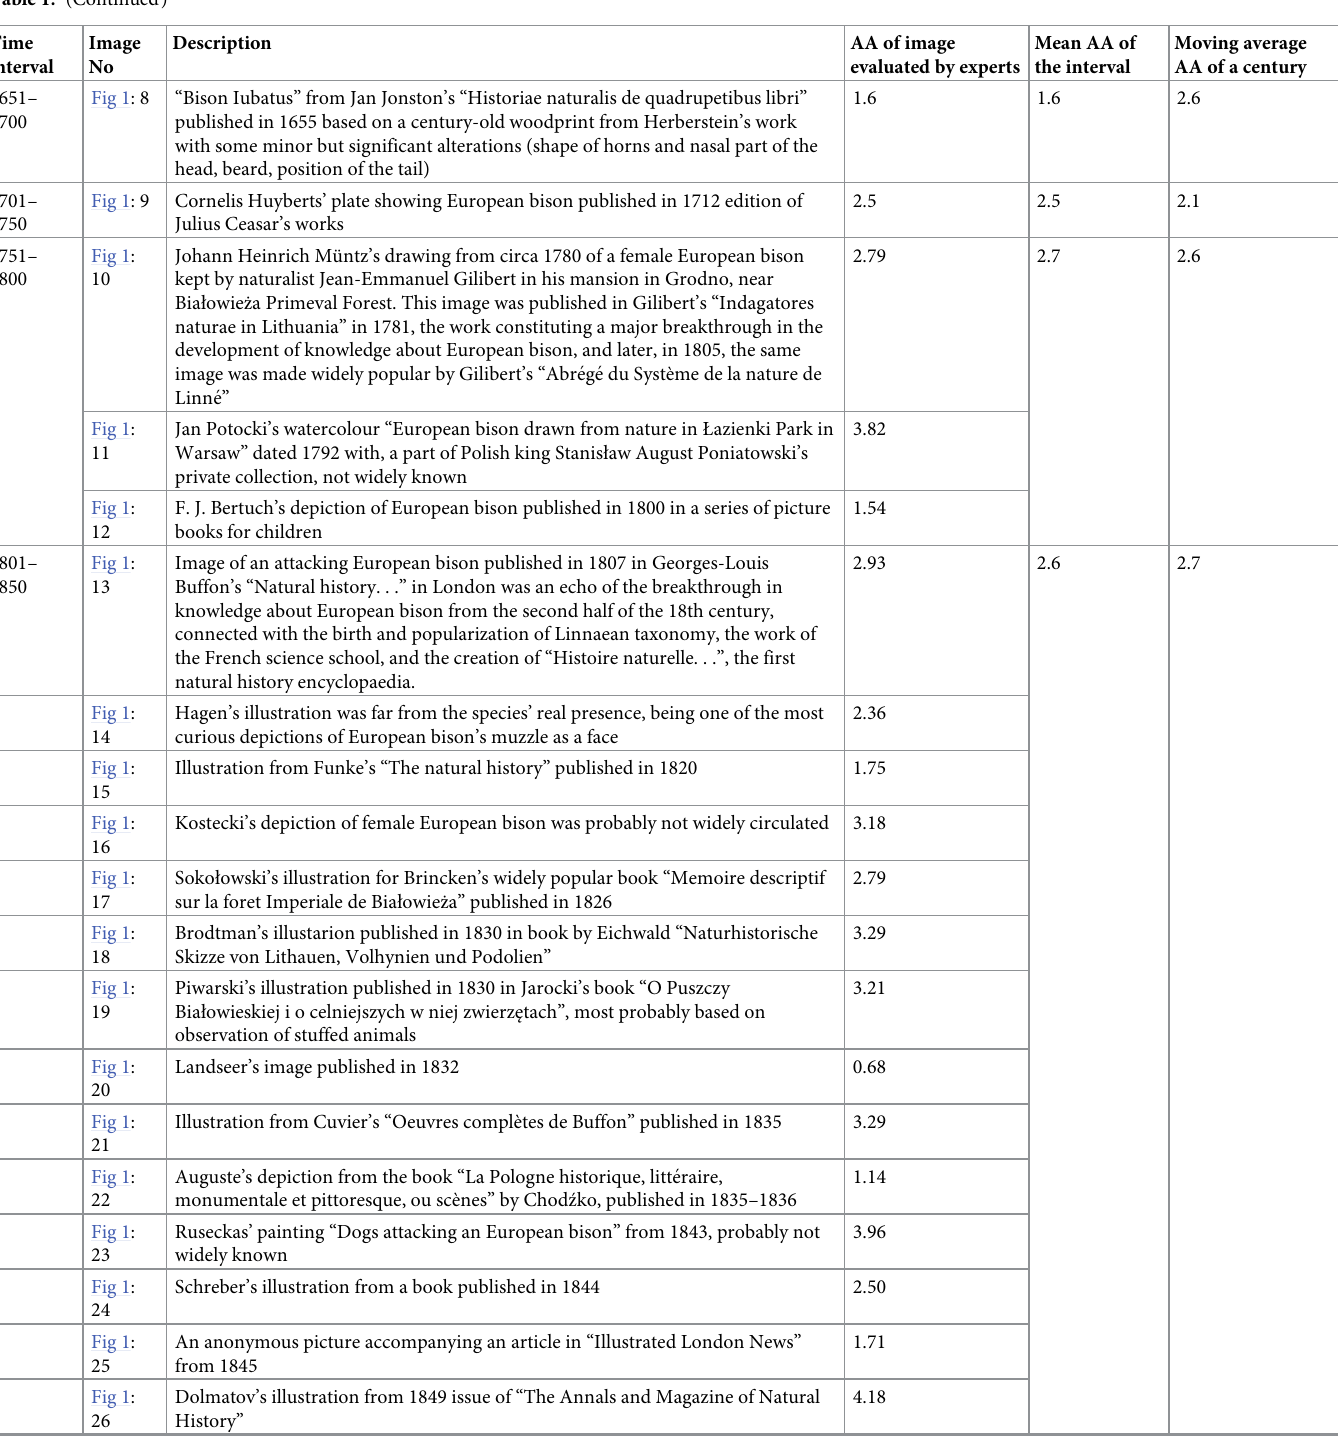
Mean AA of Moving average evaluated by experts the interval AA of a century 2.36 3.21